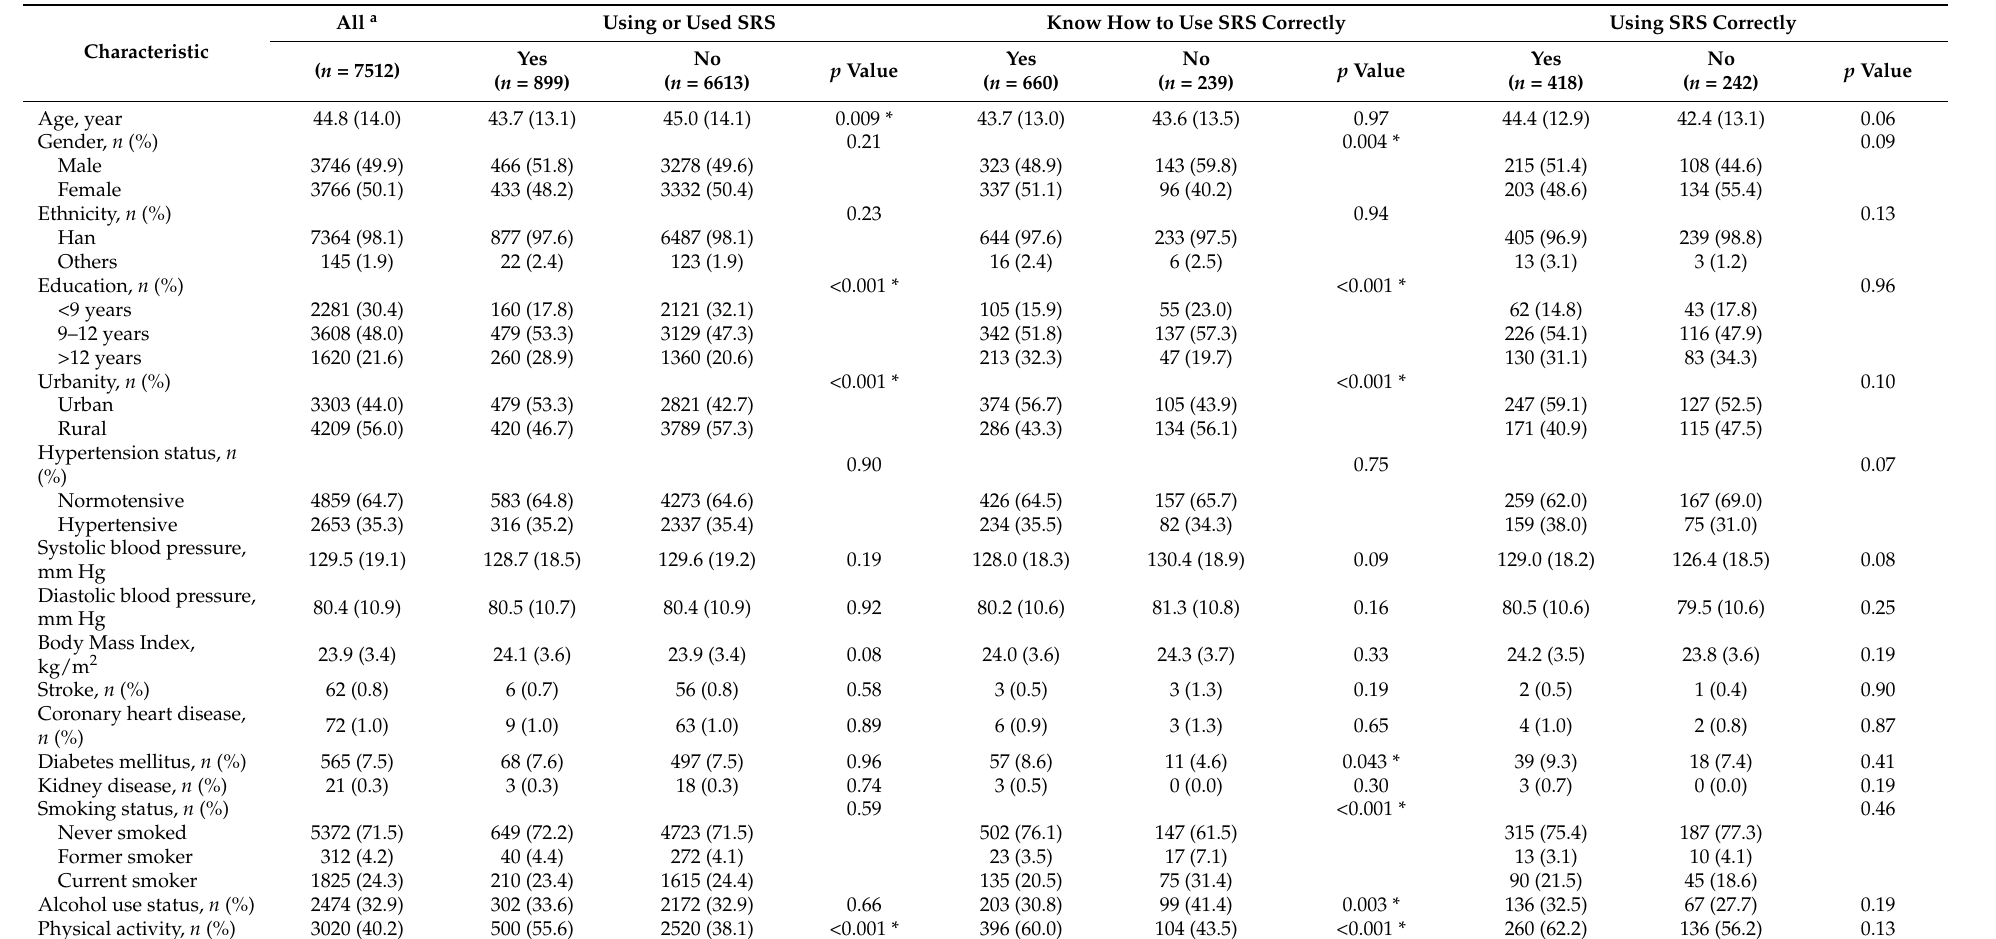
Table 1. Socio-demographic characteristics of 7512 participants by salt-restriction spoon